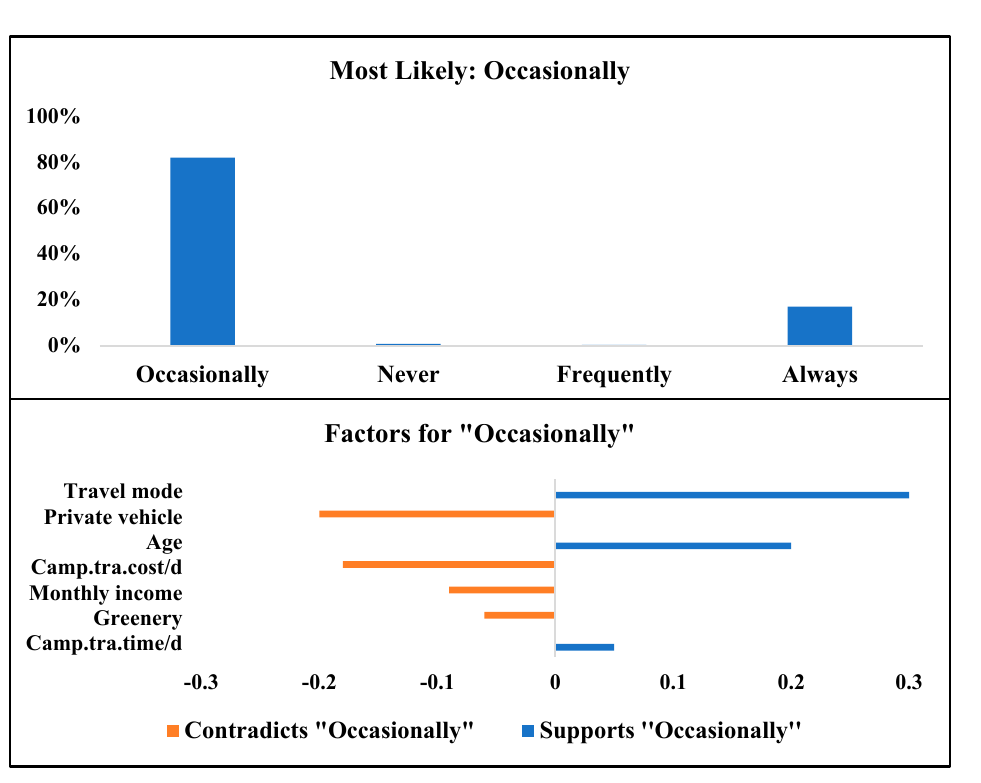
Figure 16. Optimization results and importance of variables based on the second scenario: Fre- quently use SFFESs.